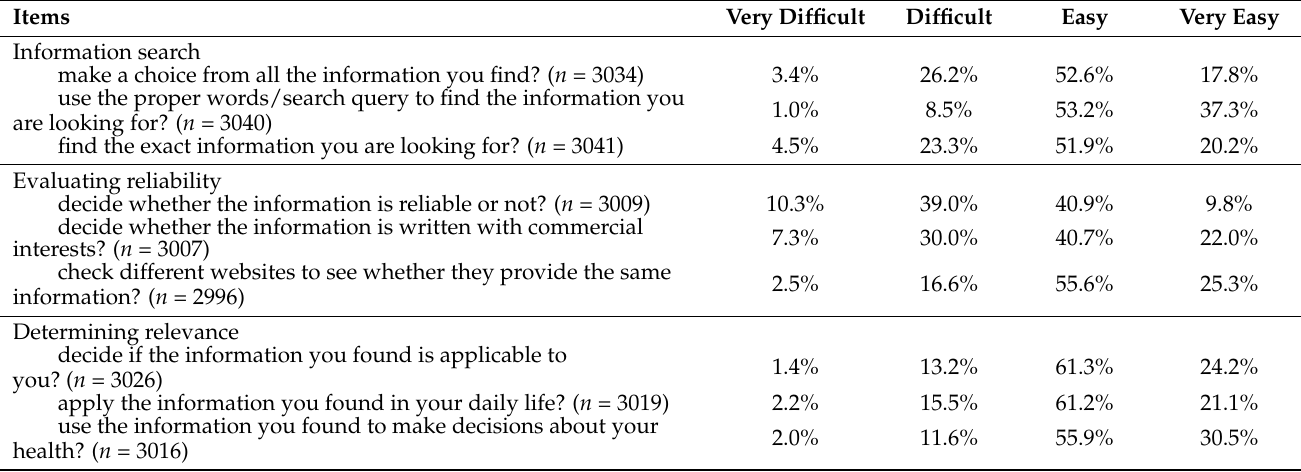
Table 2. Frequencies for all DHLI